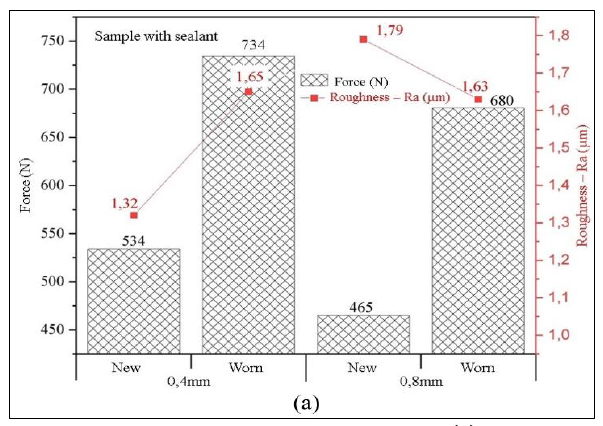
Figure 11a: Machining force x surface finish: (a) Samples with sealant.